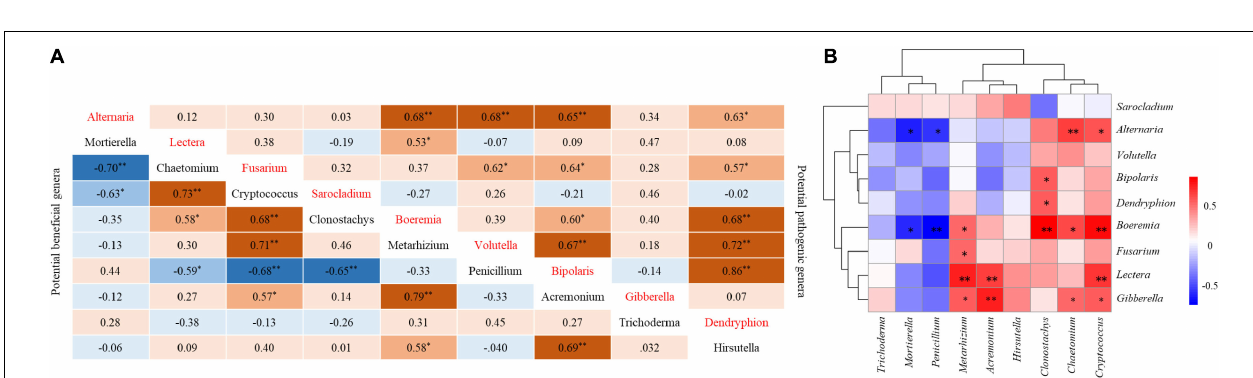
Frontiers in Plant Science |